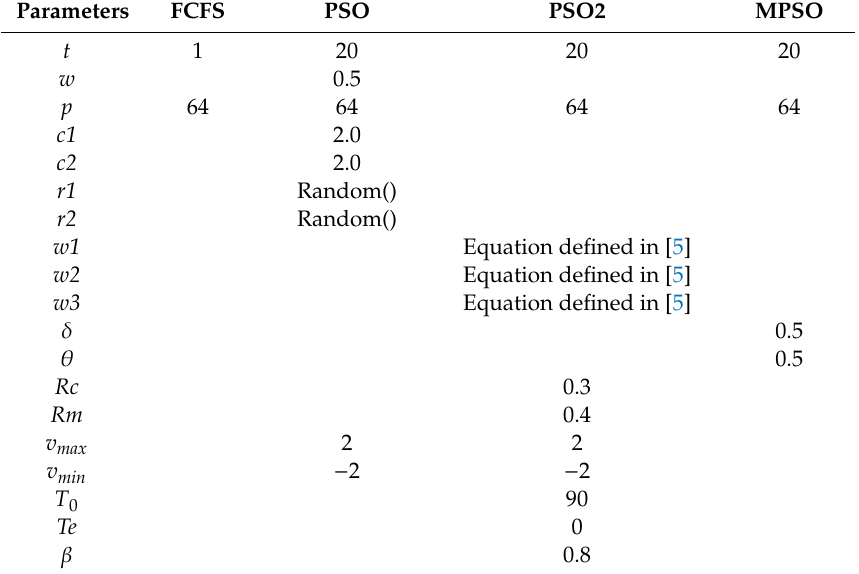
Table 1. The parameters setting for the four approaches for experiments.